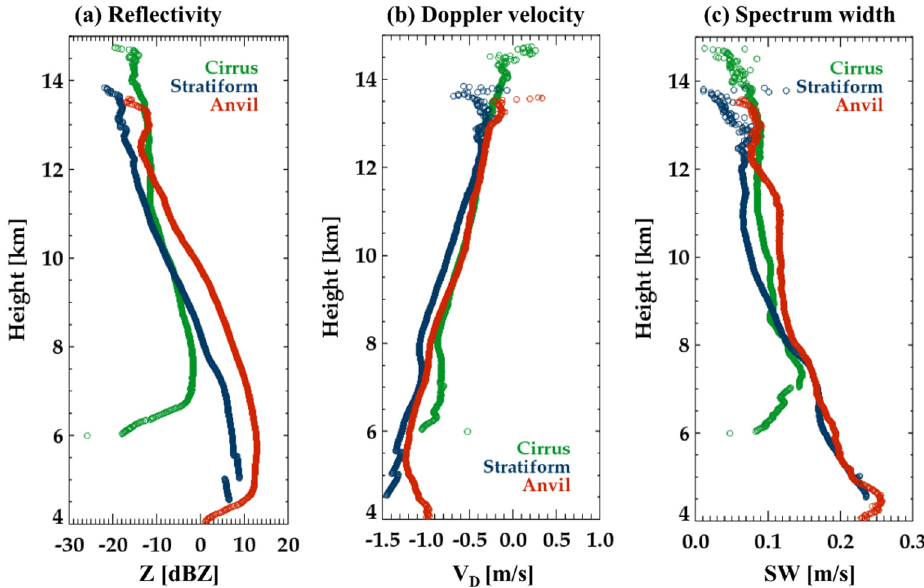
Figure 7. Mean vertical profiles of ( a ) Z , ( b ) V D , and ( c ) SW for three types of ice clouds. Green: cirrus, blue: stratiform, and red: anvil.